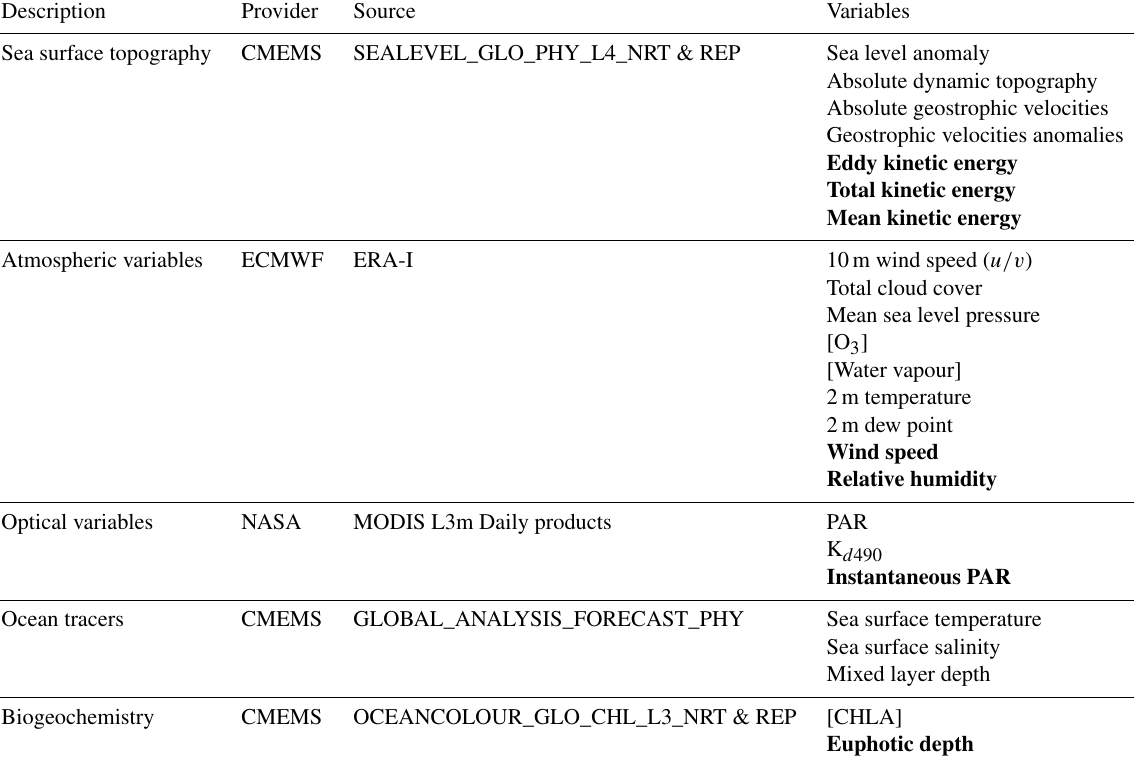
Table 3. List of SEO and reanalysis variables used to support glider missions. Bold type variables are derived by the primary production